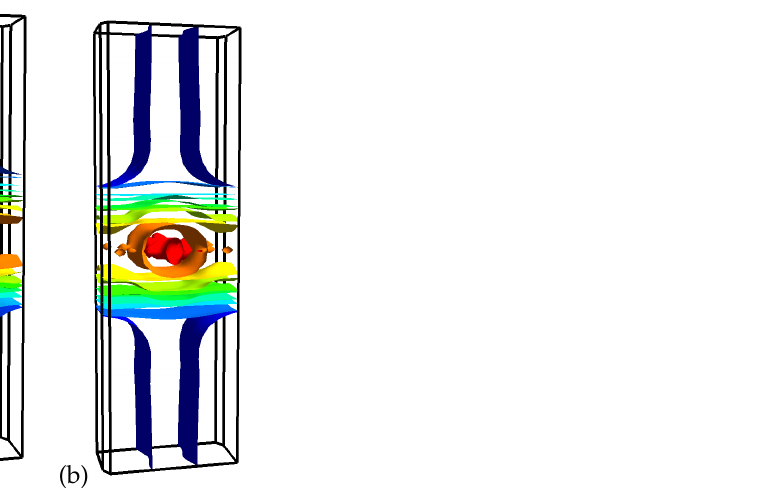
Figure 5. Comparison of the DFT-calculated Fermi surface for W 20 O 58 with SOC ( a ) and without SOC ( b ).